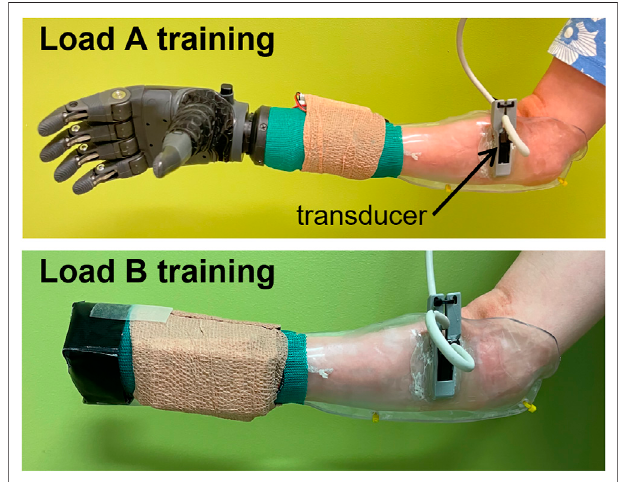
FIGURE 1 | Classi fi er training was performed with all distal components attached during the load A condition and with a weight equal to the participant ’ s clinically-prescribed prosthetic hand during the load B